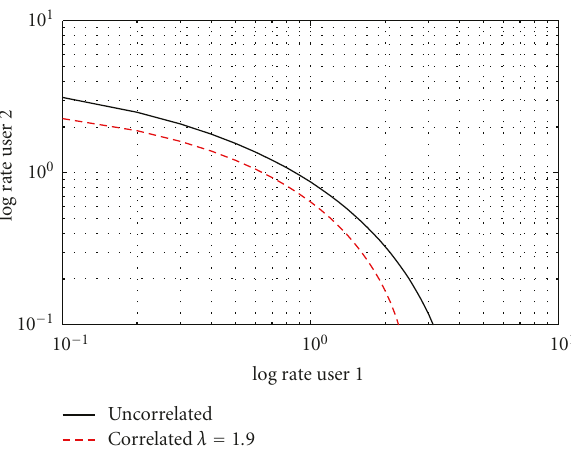
Figure 6: Zero-outage capacity region with and without superpo- sition coding and with full collisions compared to perfect CSI and nonlinear and linear precoding with and without time-sharing for SNR 10 dB.